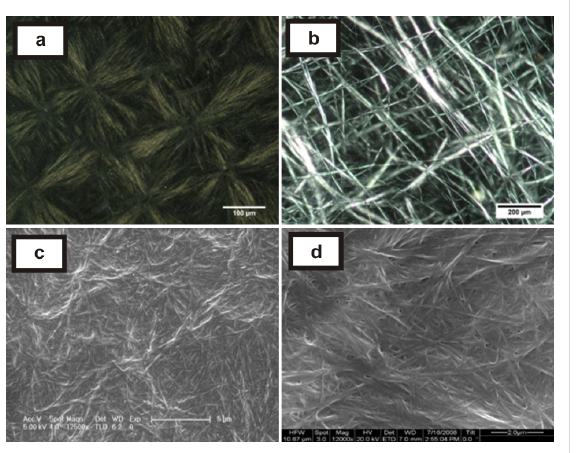
Figure 4: (a) and (b) POM images of the gels of diethylaminolitho- cholyl iodide 1 in 1,2-dichlorobenzene (1.25 and 0.25% w/v of